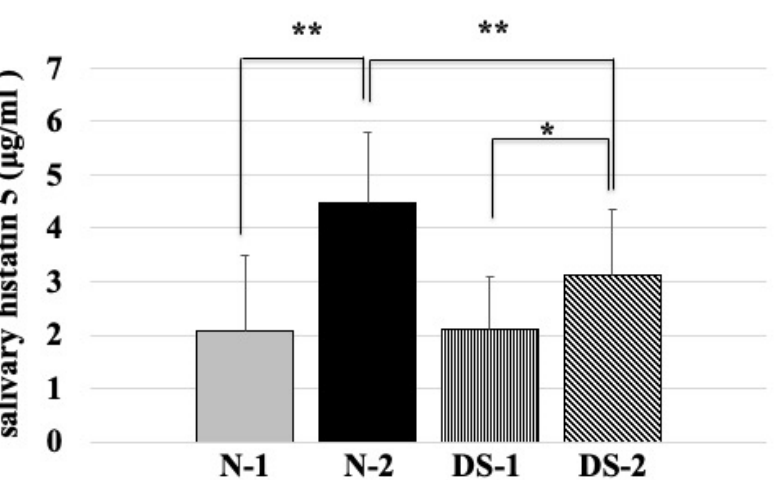
Figure 4. Comparison of salivary histatin 5 concentrations between the Down syndrome (DS) and normal (N) groups. The DS and N groups were subdivided according to age, with the first group consisting of DS (DS-1) and normal (N-1) subjects under 20 years of age, and the second group consisting of DS (DS-2) and normal (N-2) subjects over 40 years of age. The sex composition and mean age of the study groups are shown in Table 1. One-way ANOVA test results of comparing salivary histatin 5 concentration in four groups and the pairwise comparison using Scheffe’s test for all four groups. ** p < 0.01; F-value 16.59.